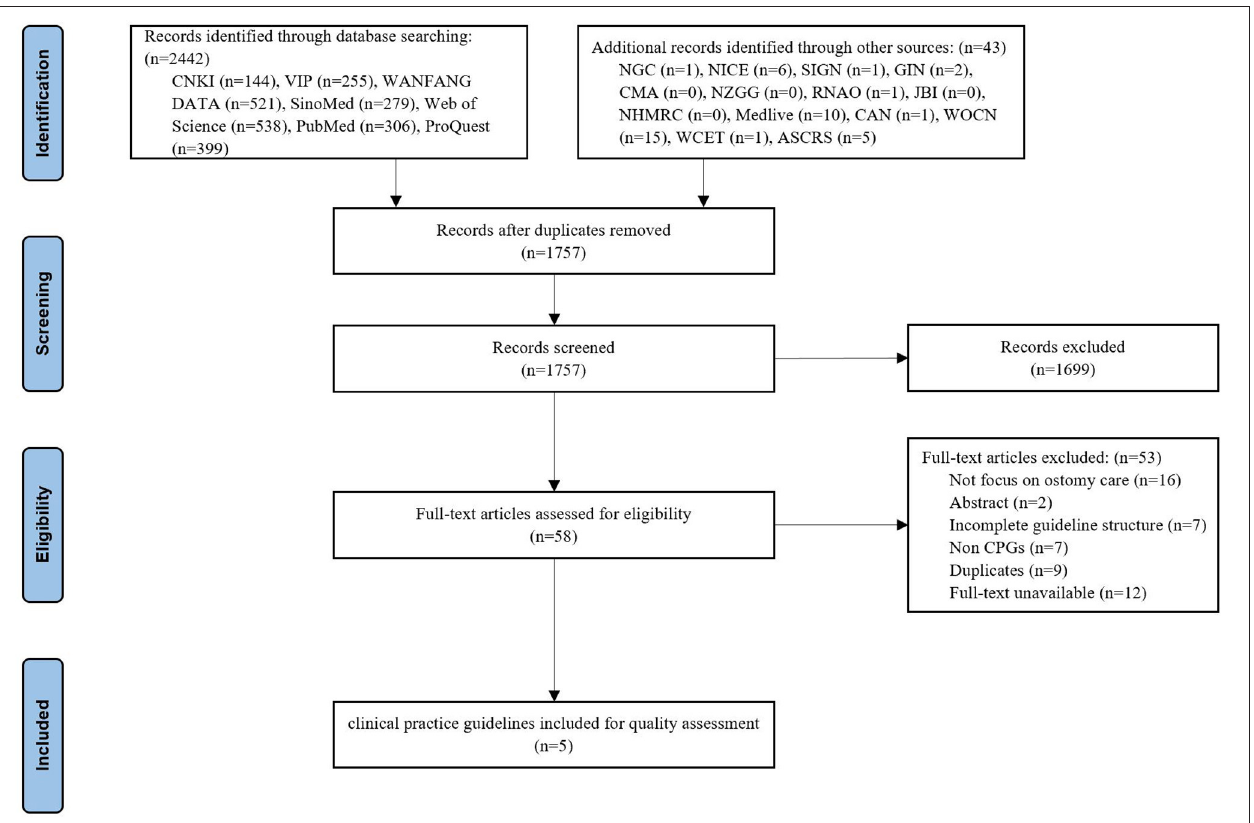
FIGURE 1 | Flow diagram outlining the guideline selection